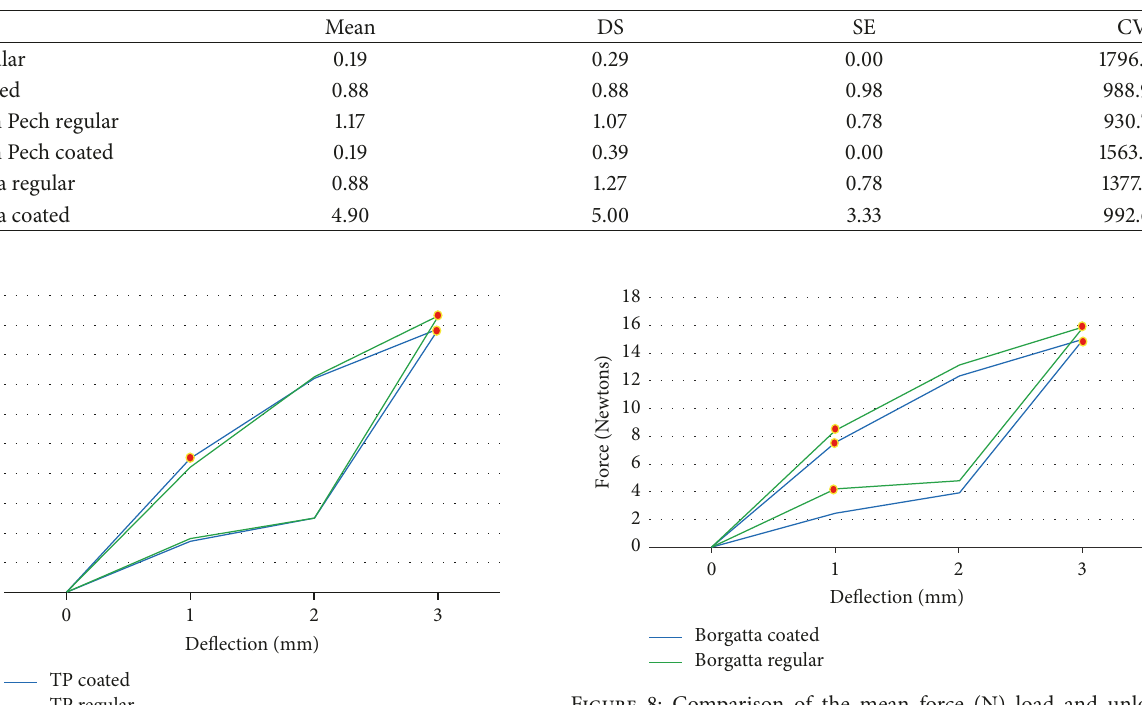
Table 4: Comparisons of the mean force (N) of the permanent deflection between the coated and regular Ni-Ti wires by manufacturer.